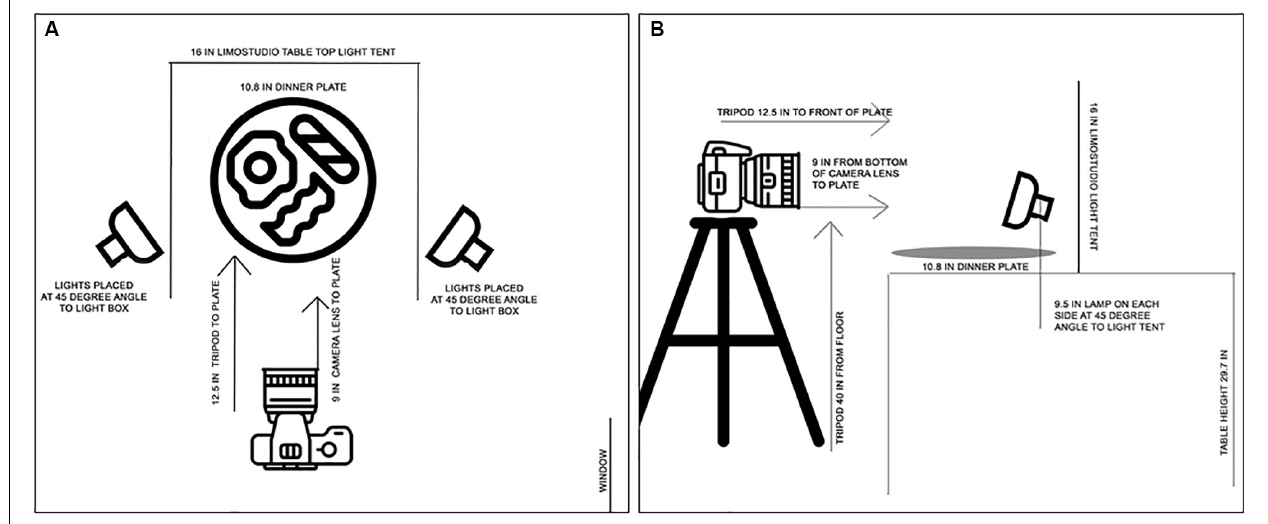
FIGURE 1 | Diagram depicting placement of food or office supplies on a plate in relation to camera, tripod. lights. and light box used in photography protocol. (A) Shows the bird’s-eye view of the equipment and objected of interest photographed by the professional photographer. (B) Shows the eye level view of the equipment and object of interest photographed by the professional